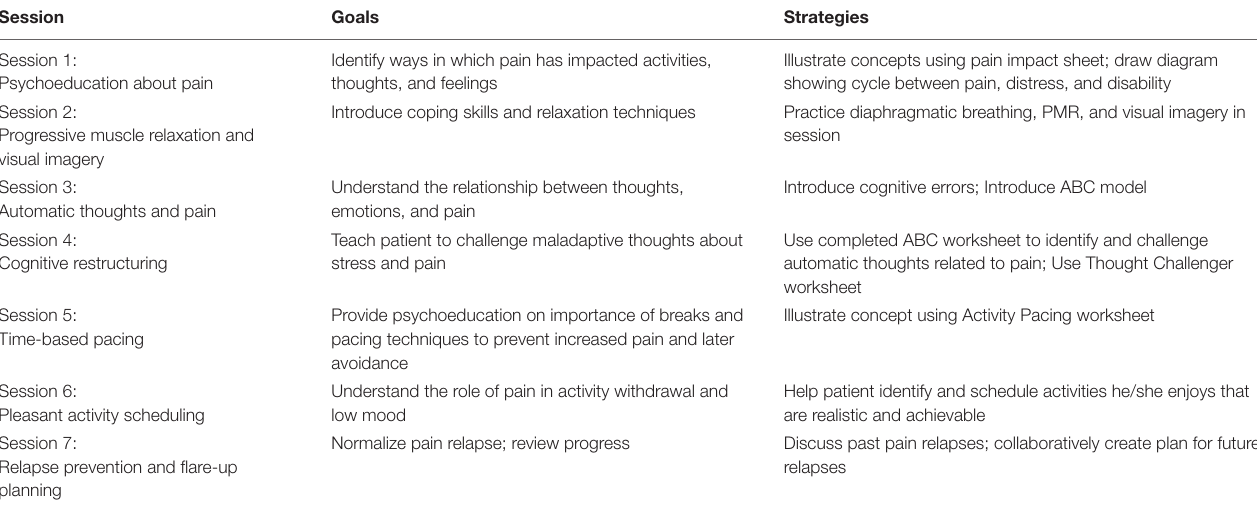
TABLE 1 | Session goals and strategies of pre-surgical CBT intervention. Session Goals